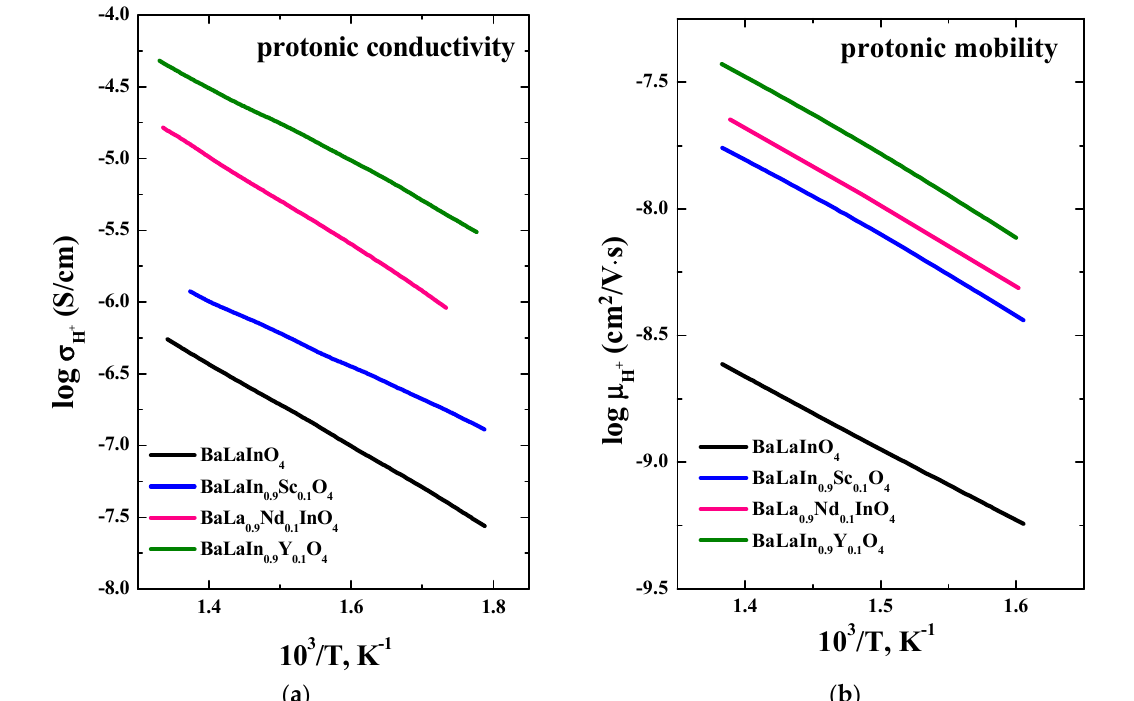
Figure 8. Dependencies of protonic conductivity ( a ) and mobility ( b ) from temperature for the compositions BaLa 0.9 Nd 0.1 InO 4 , BaLaIn 0.9 Sc 0.1 O 4 [54], BaLaIn 0.9 Y 0.1 O 4 [55], BaLaInO 4 [49].